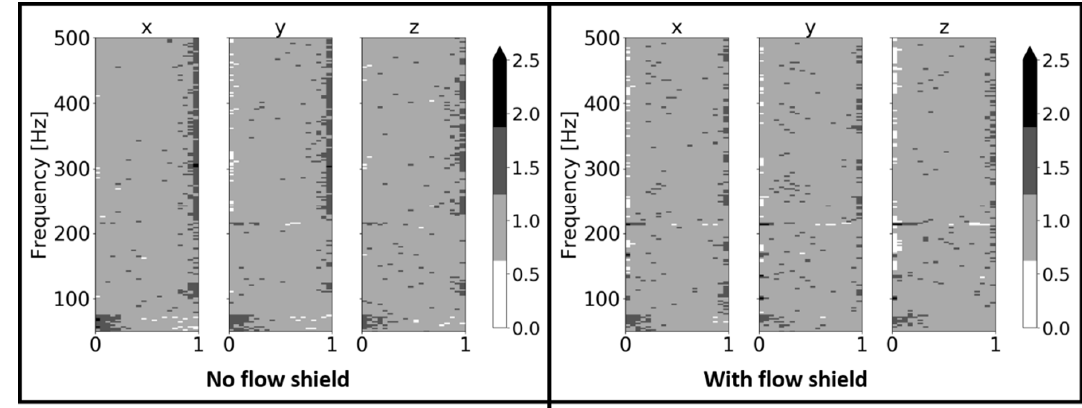
Figure 7. Probability distribution of M2j metric, with and without a flow